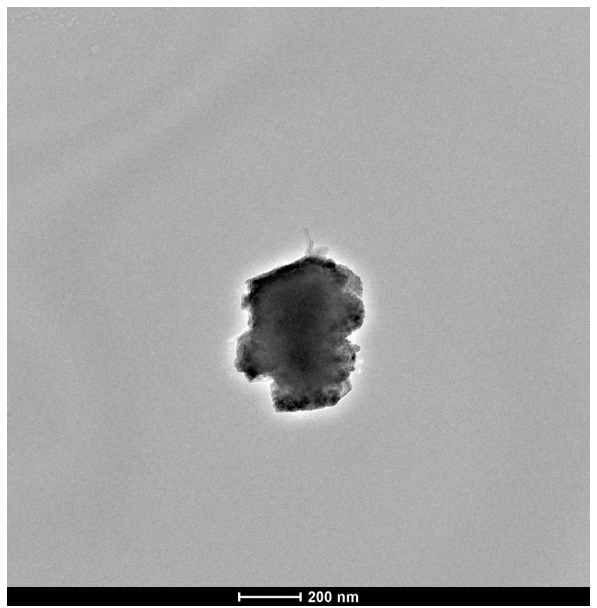
Figure 15. TEM image of an O-, S-, Ti-, Sr-, and Ba-containing particle from a deep-seated oxidized zone in the Dongshengmiao deposit.